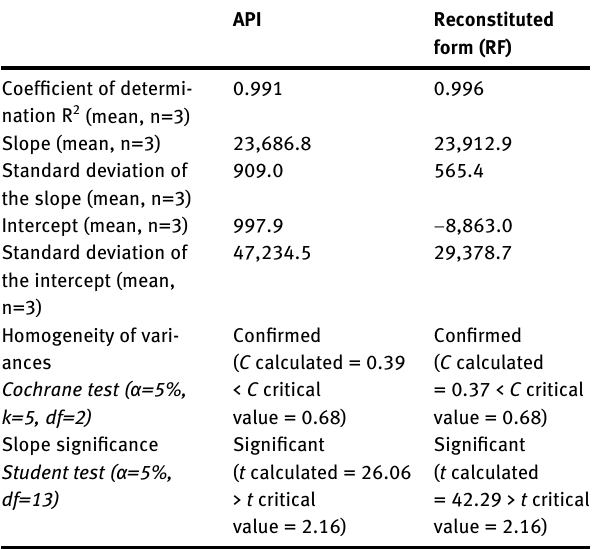
Table  : Linearity data of HPLC-UV method.